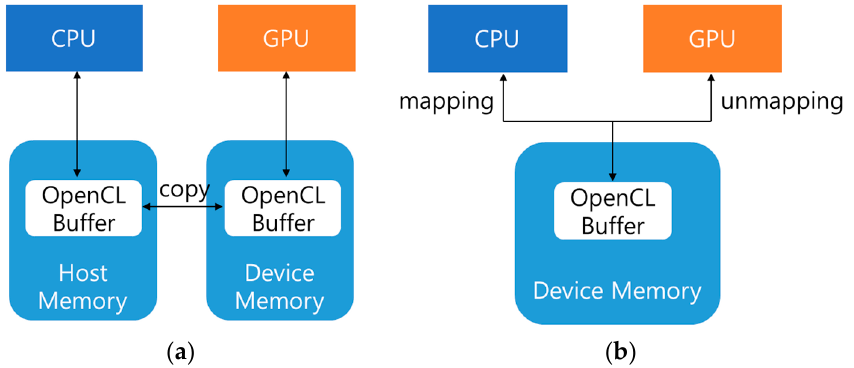
Figure 3. Comparison of memory architecture with and without unified memory. ( a ) Memory architecture without unified memory, ( b ) Memory architecture with unified memory.